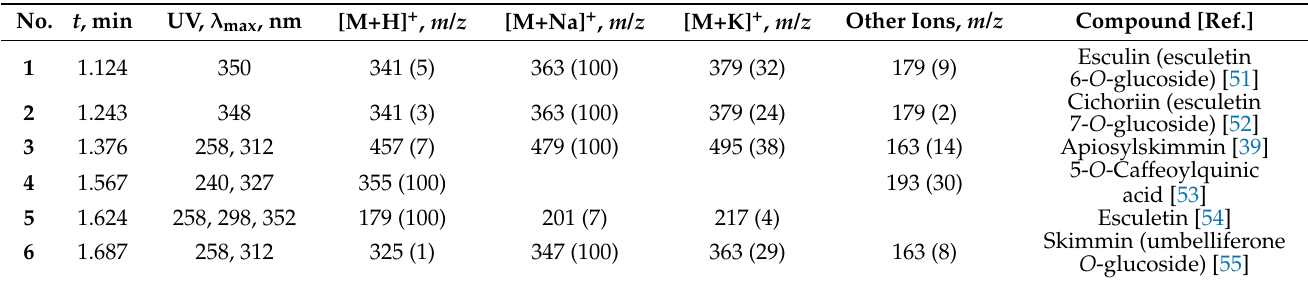
Table 2. Chromatographic ( t ), ultraviolet (UV) and mass-spectrometric data (MS) of compounds 1 – 25 found in L. officinale fresh